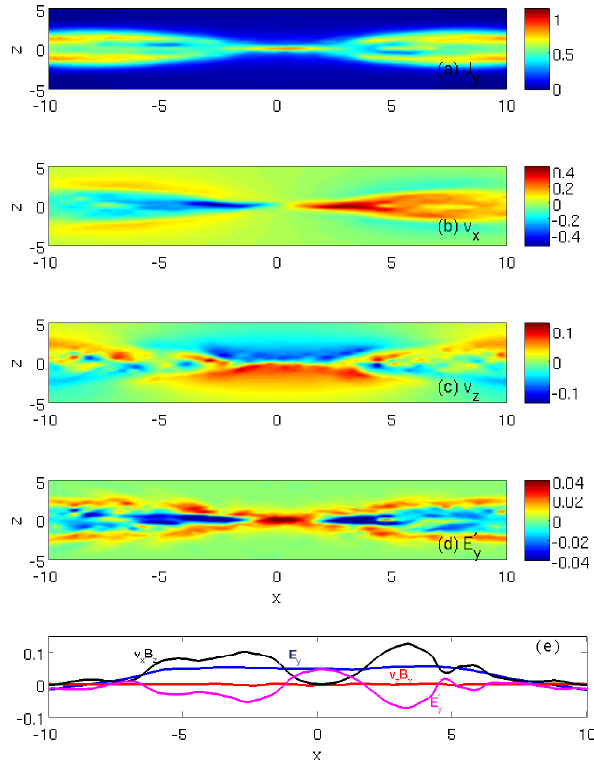
Fig. 2. The variables (a) J y , (b) v x , (c) v z and (d) E 0 y = [ E + v e × B ] y in the initial stage of simulations ( t = 50). The cuts along z = 0 of E 0 y (magenta), v x B z (black), v z B x (red) and E y (blue) are shown in (e)